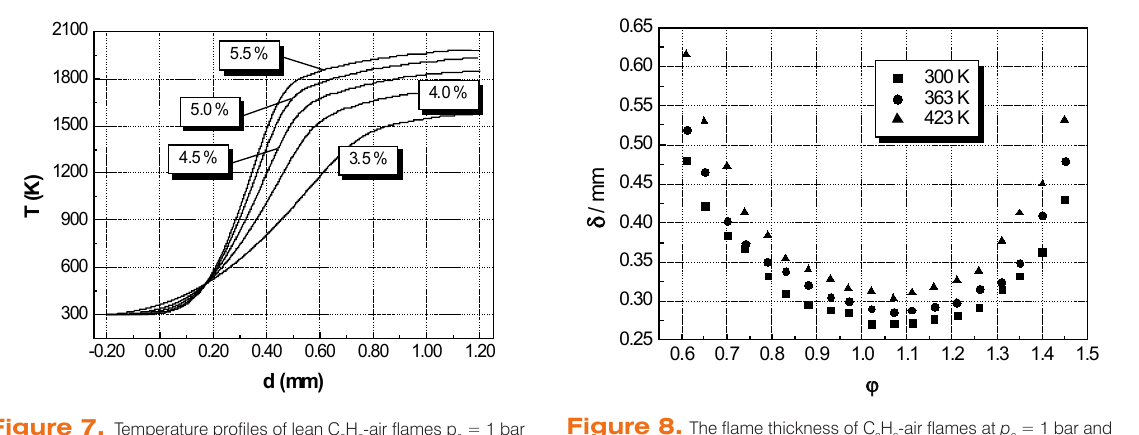
various initial temperatures.